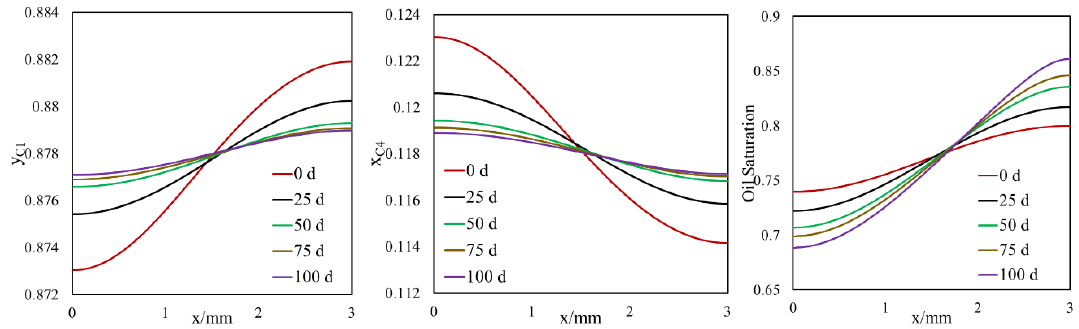
Figure 21. ( a ) Methane composition in gas phase ( b ) Butane composition in the liquid phase ( c ) Oil saturation profile, results are without Pc in flow and with diffusion, ternary mixture.